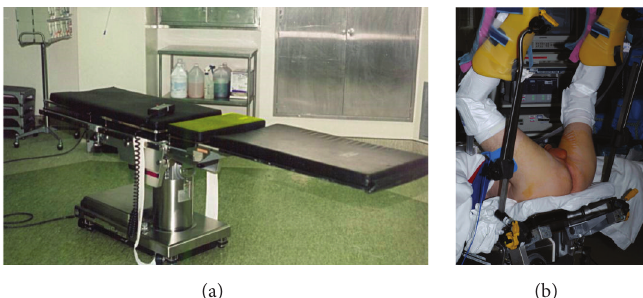
Figure 7: (a) Modified Skytron Custom 6000 Surgical Table with pelvic tilt mechanism (highlighted in yellow). (b) Patient positioned in exaggerated